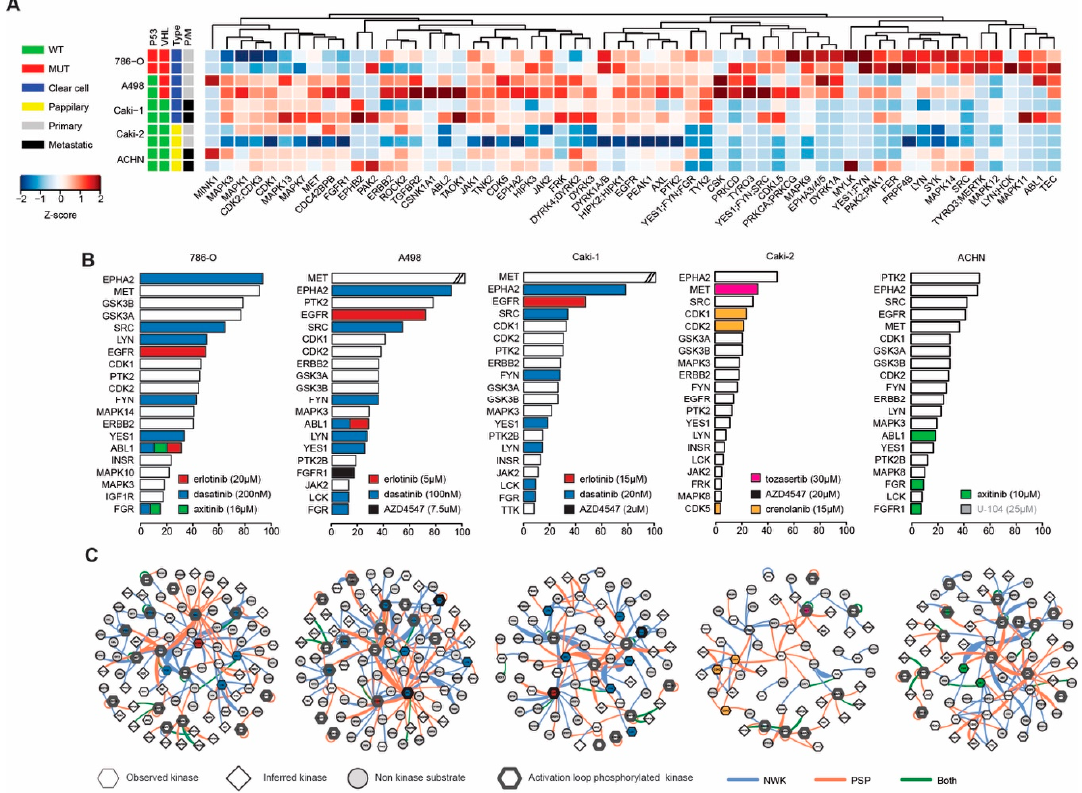
Figure 3. Phosphoproteomic profiling of RCC lines. ( A ) Heatmap of active (phosphorylated) protein kinases expressed in RCC under routine culture conditions. Samples are color coded according to column Z-scores. ( B ) Integrated inferred kinase activity analysis (INKA) ranking of kinase activity based on both kinase and substrate data for all RCC. Kinases are color coded for targeting drugs in the respective ODCs. ( C ) Network analysis of proteins with a positive INKA score. Drug targets are color-coded as in ( B ), and shaped according to INKA evidence. Blue lines indicate evidence by NWK, orange by PSP and green by both. A representative example of the duplicate analysis is shown for ( B , C ).